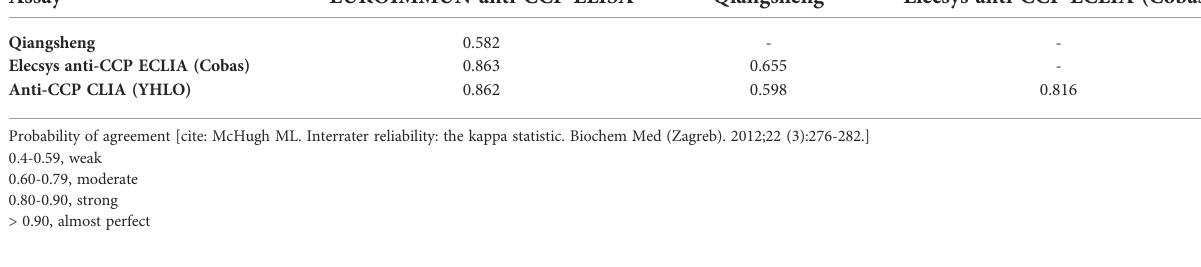
Table 3 Kappa statistic.